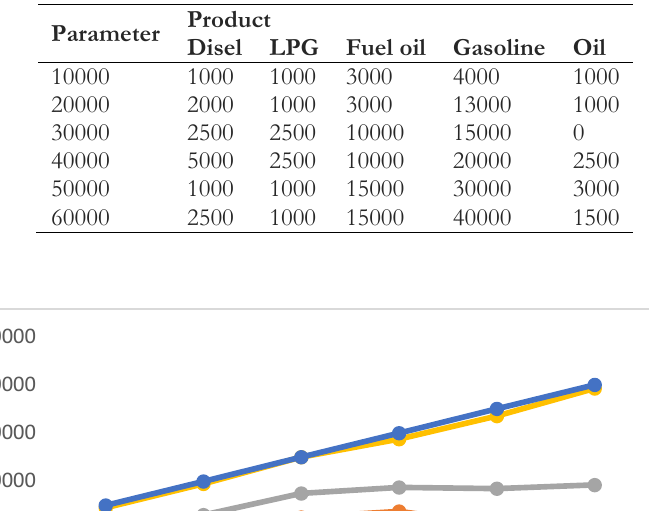
Table 6. Changing maximum capacity on product quantity.